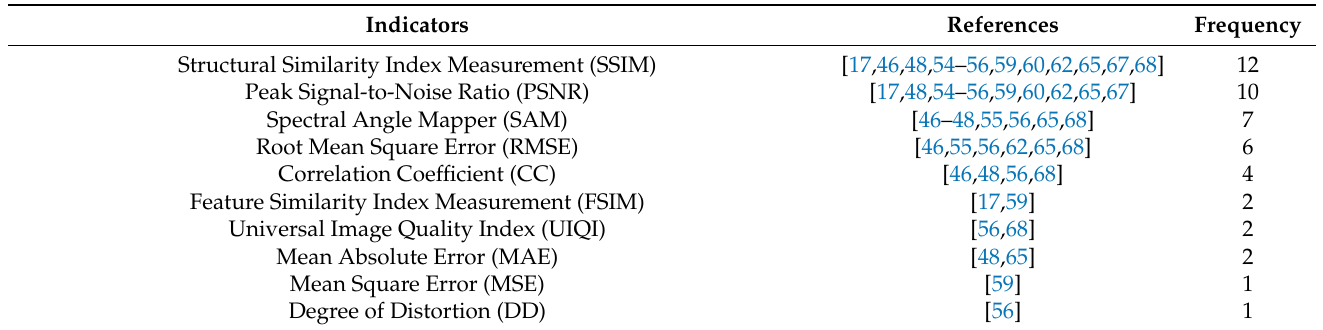
Table 4. Different input of the existing cloud removal methods of optical remote sensing imagery using